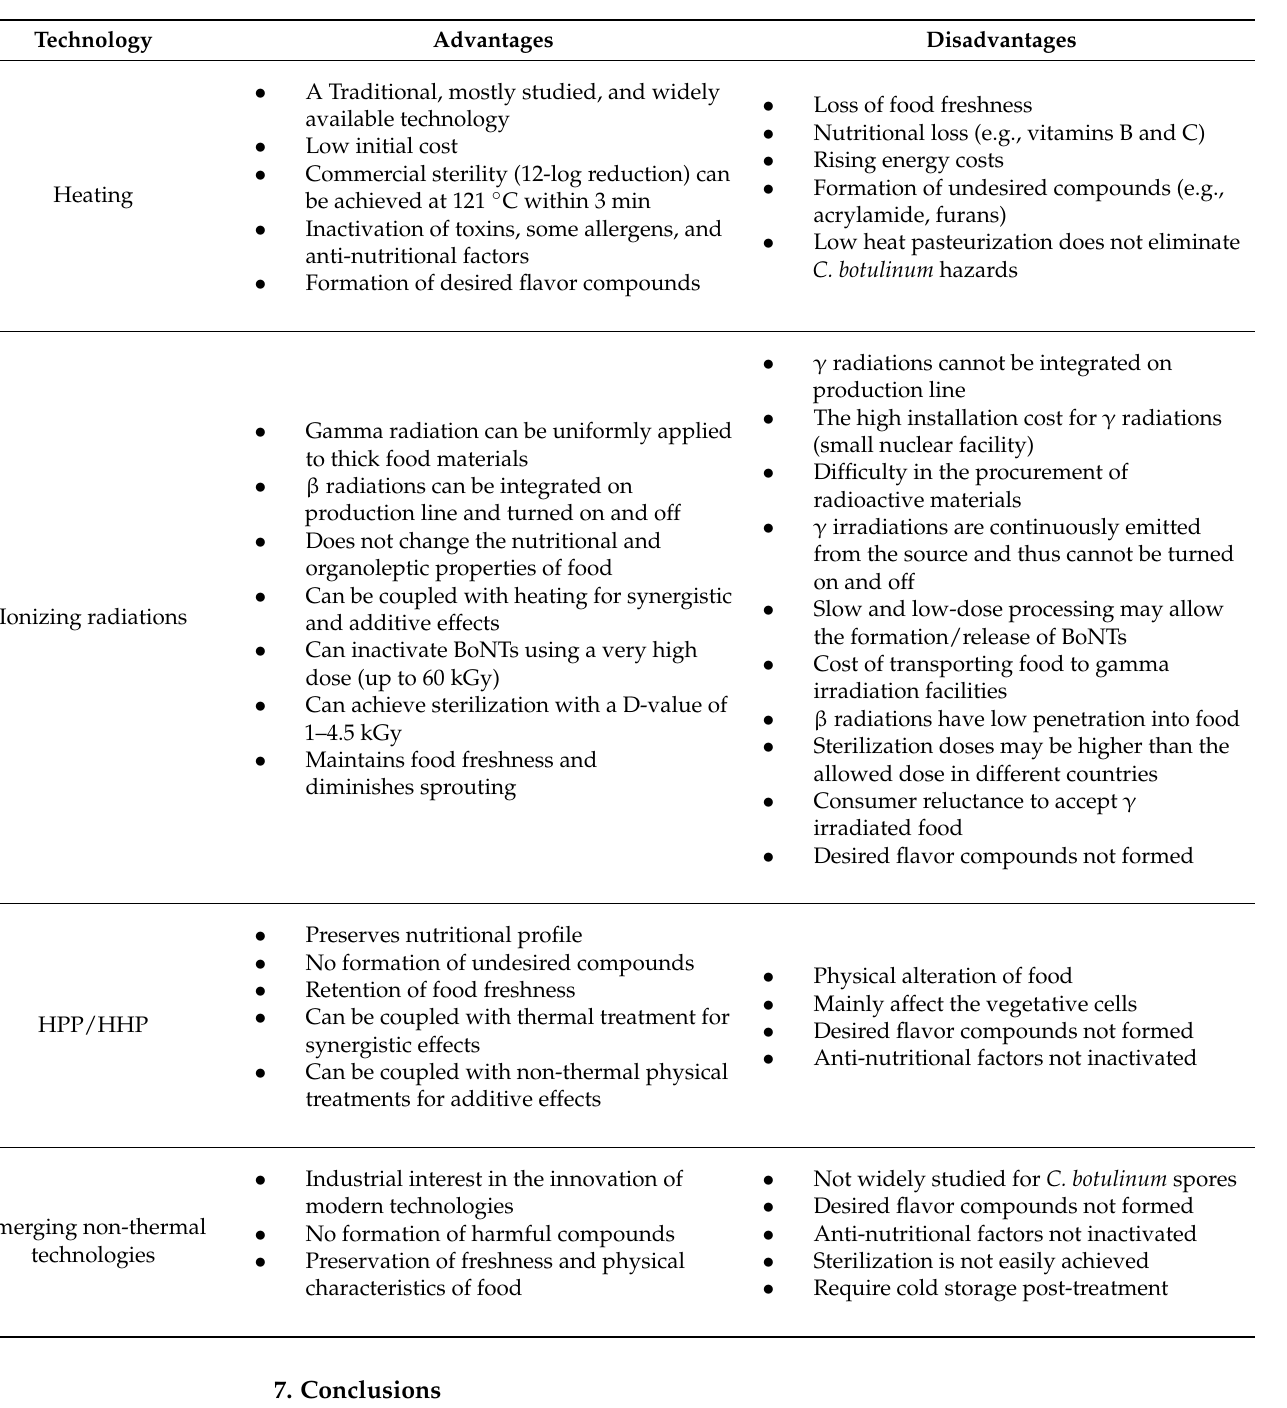
Table 6. Advantages and disadvantages of different physical treatments regarding food quality, employability, and potential to control C. botulinum